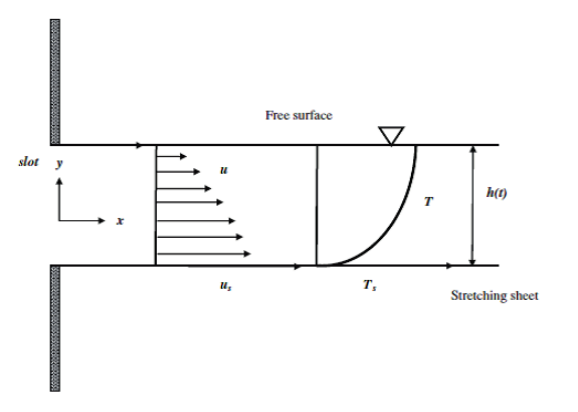
Fig. 1: Physical model and coordinate